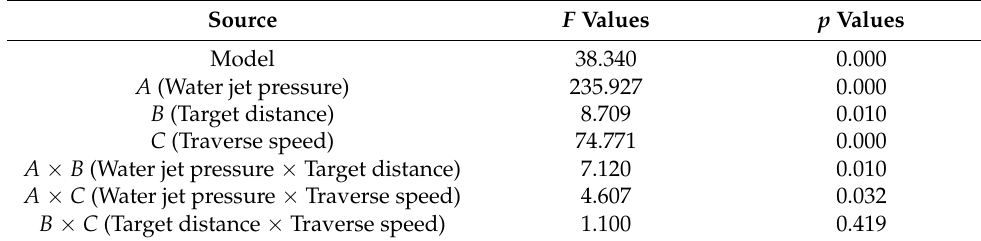
Table 3. Results of the analysis of significance.